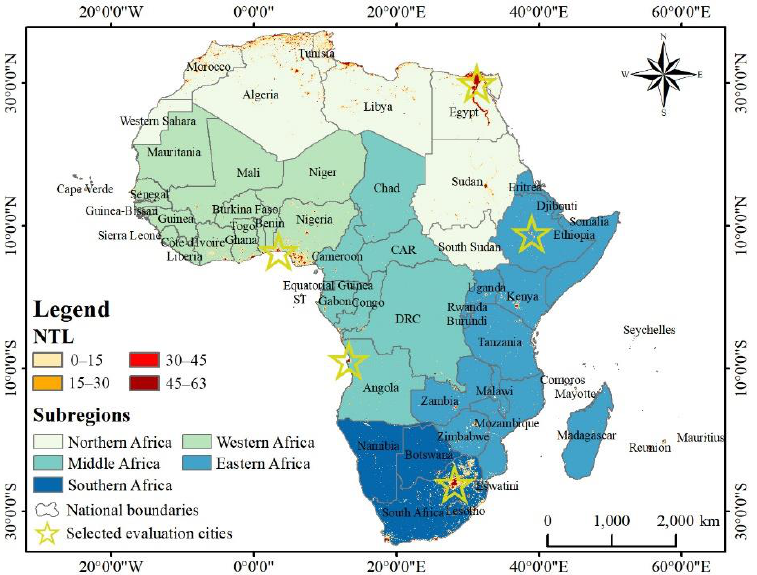
Figure 1. Nighttime light (NTL) image in 2013, of subregions and selected evaluation cities for Africa.